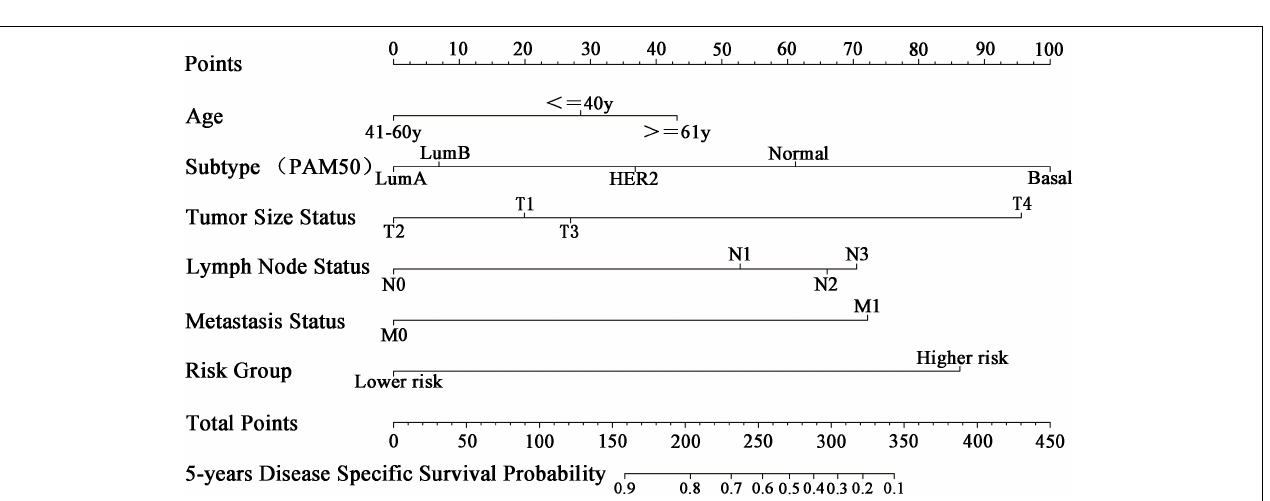
FIGURE 8 | KM curves for patients in different risk subgroups. KM analysis showing that patients in the high-risk (A) but not the low-risk (B) subgroup who underwent adjuvant chemotherapy had significantly better prognosis than those who did not receive adjuvant chemotherapy.